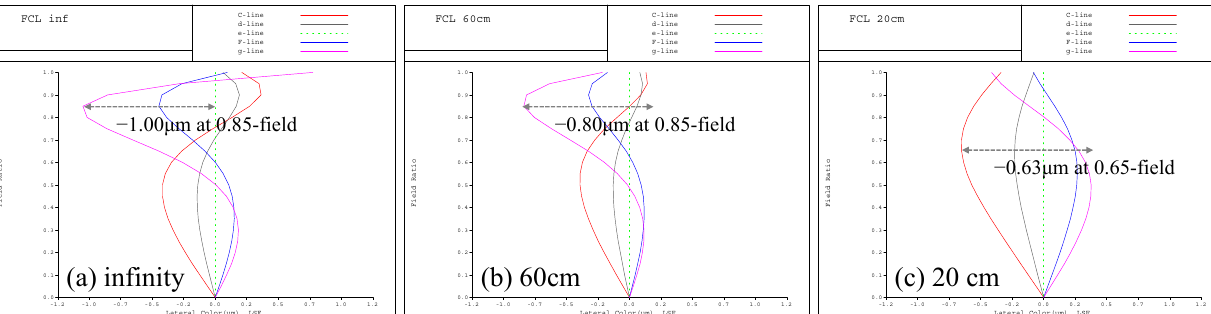
Figure 8. Lateral color of our designed collimator.